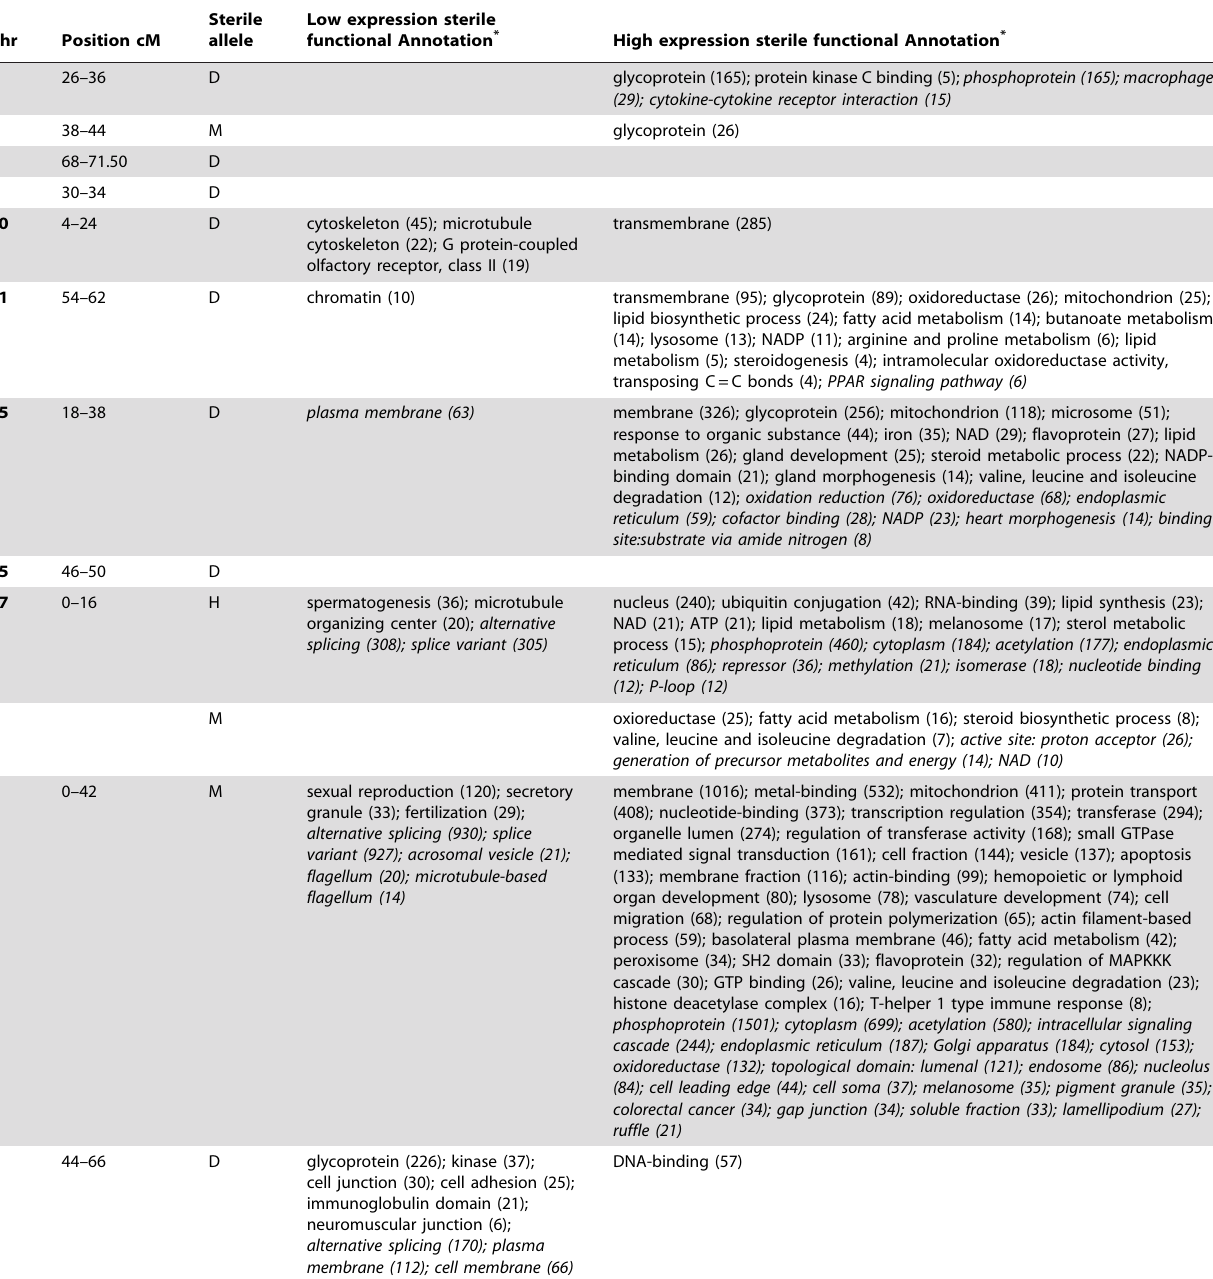
Table 3. Functional annotation of QTT associated with trans eQTL